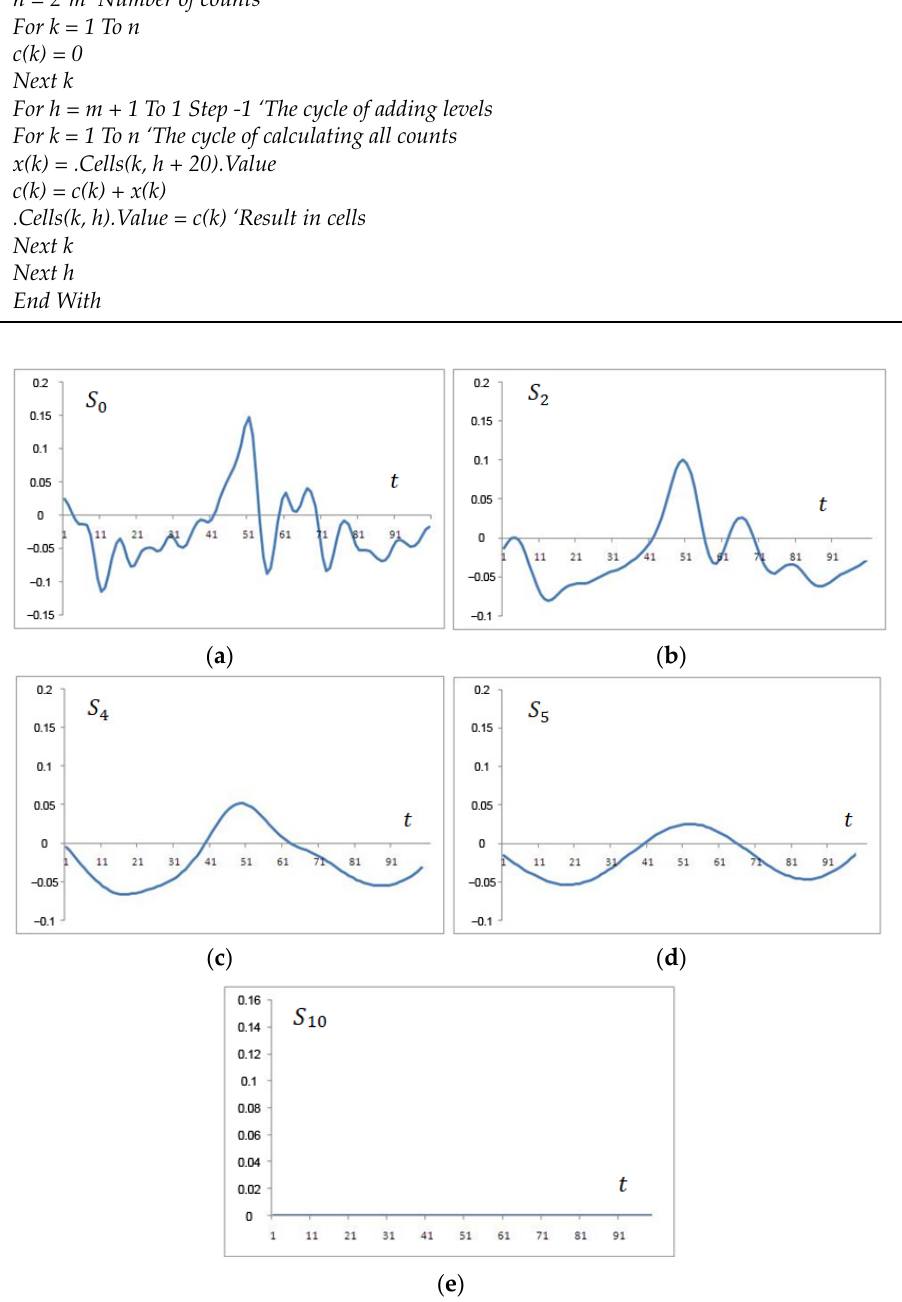
Figure 2. Multiple-scale analysis of the function: ( a ) the signal obtained by adding all the decomposi- tion levels, ( b ) the approximation of the signal obtained by adding 10-2 levels, ( c ) the approximation of the signal obtained by adding 10-4 levels, ( d ) the approximation of the signal obtained by adding 10-5 levels, and ( e ) the roughest approximation of the signal obtained by adding only 10